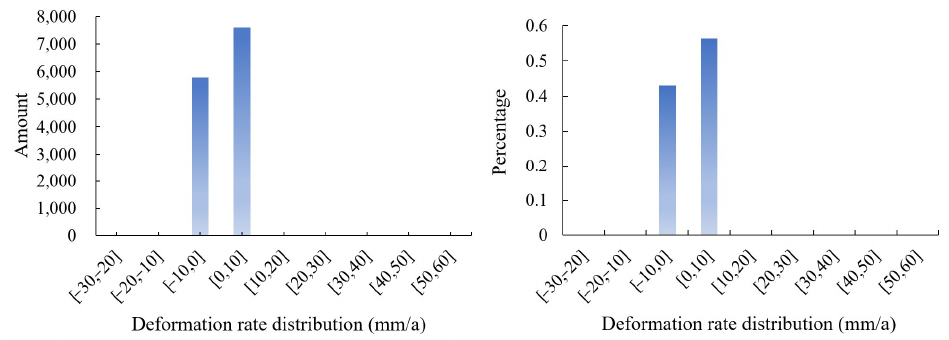
Figure 8. Histogram of deformation rate range (Unit: mm/a).